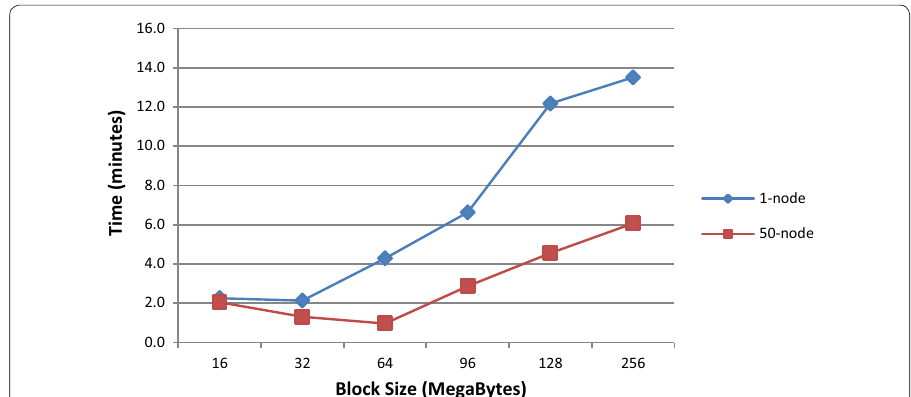
Fig. 26 Comparing the average shuffle time for running k-means with 1.9 GB raster image in 2 and 50 nodes Hadoop cluster